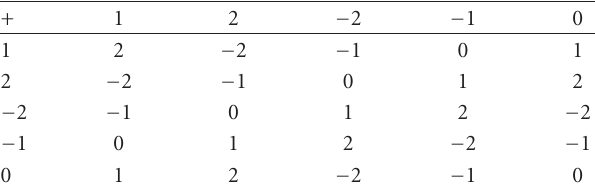
Table 1: Addition table for { 1,2, − 2, − 1,0 } .